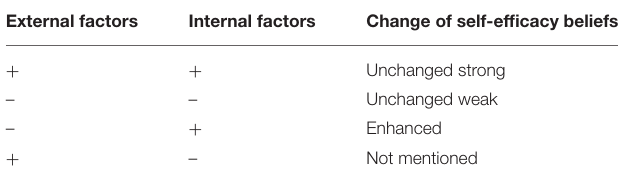
TABLE 4 | Summary of